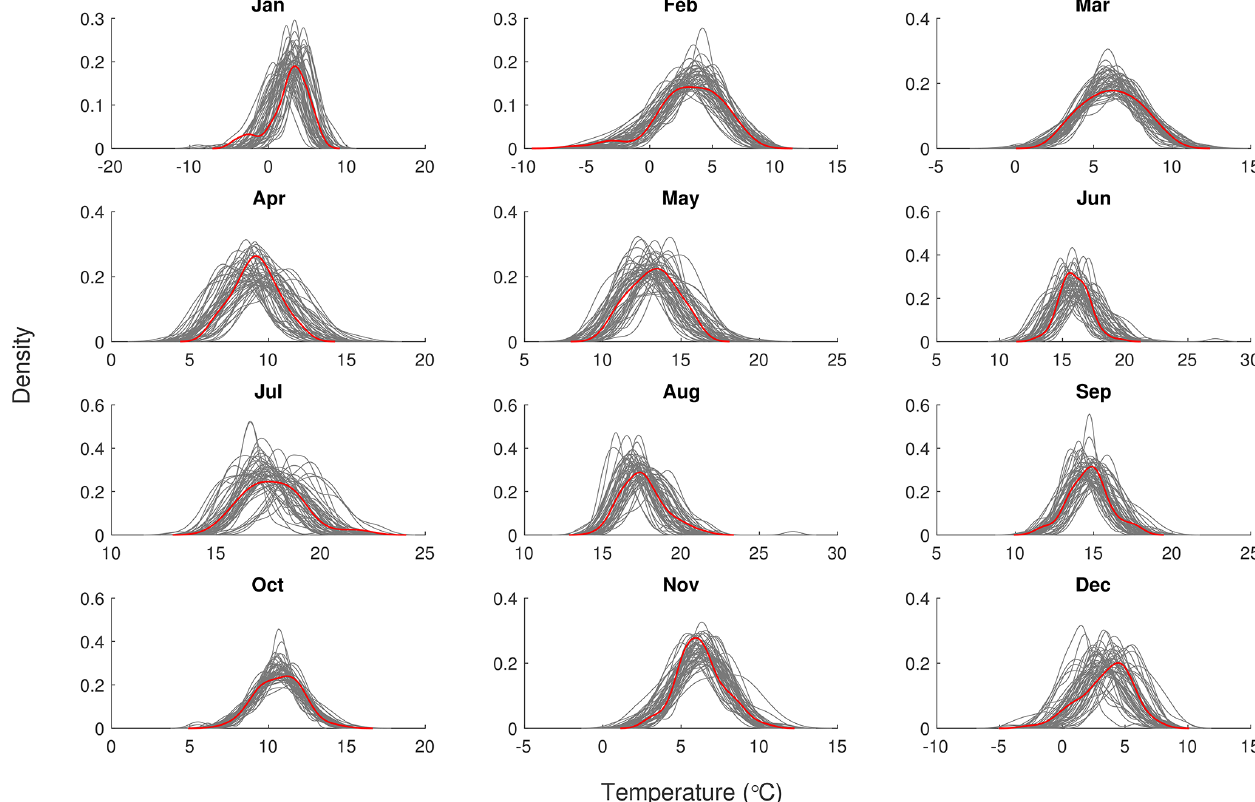
is in grey. p PT